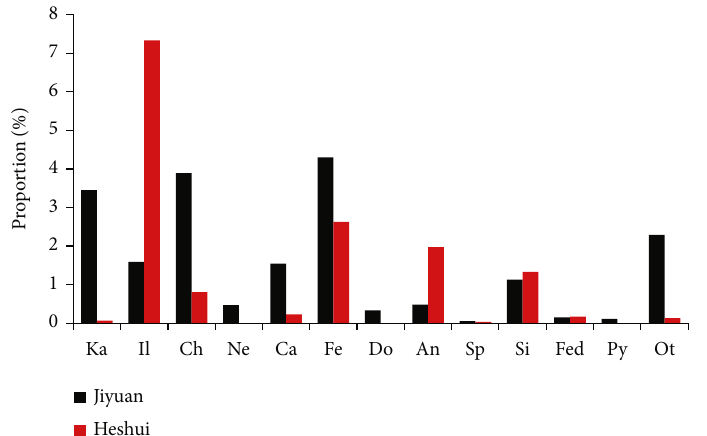
Figure 5: Interstitial materials in the research areas. Ka: kaolinite; Il: illite; Ch: chlorite; Ne: ne; Ca: carbonate; Fe: ferrocalcite; Do: dolomite; An: ankerite; Sp: specity; Si: silica; Fed: ferrodolomite; Py: pyrite; Ot: others.